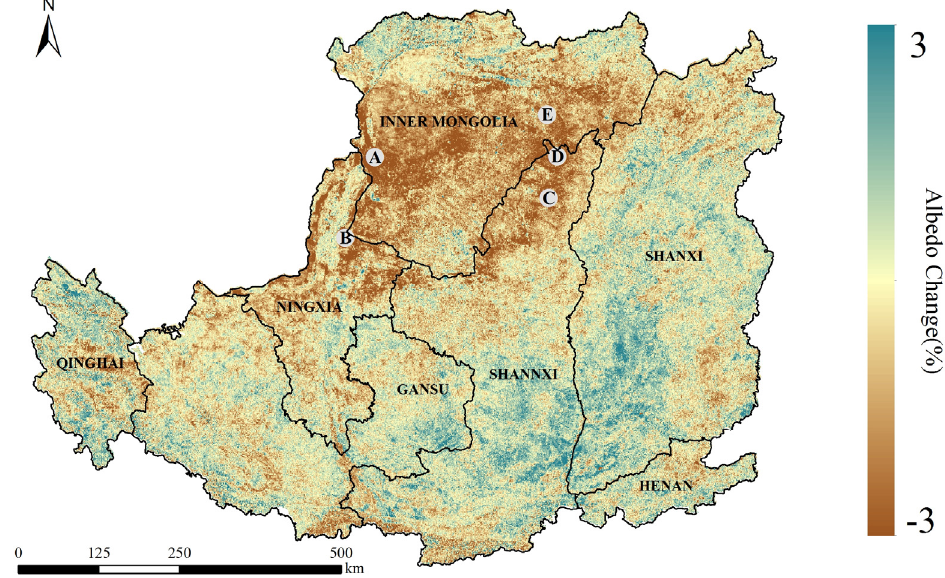
Figure 3. Peak season albedo changes from 2000 to 2010 across the Loess Plateau. Interest Regions: ( A ) Etuoke Qi. ( B ) Lingwu country. ( C )Shenmu country. ( D ) North of Shenmu. ( E ) Dongsheng